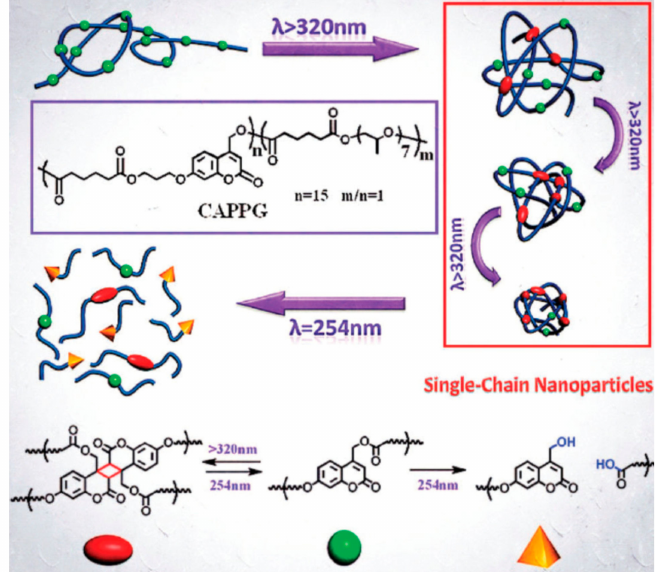
Figure 19. Schematic illustration of the formation of size-tunable SCNPs from a polyester precursor bearing coumarin moieties in the main chain (in green color ) via UV-irradiation ( λ > 320 nm) of a very dilute solution to give coumarin dimers (in red color ) and subsequent main-chain disassembly through UV-irradiation at λ > 254 nm, leading to coumarin-photocleaved fragments (in yellow color ). Reprinted from [58] with